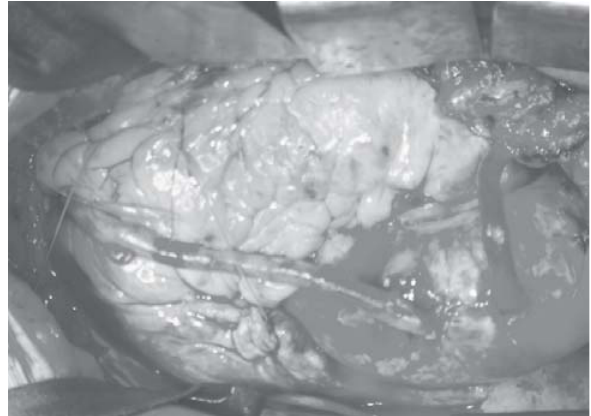
Fig. 5 - Revascularização do miocárdio com duas pontes de safena (artéria coronária direita e diagonal) e artéria torácica interna direita para a interventricular